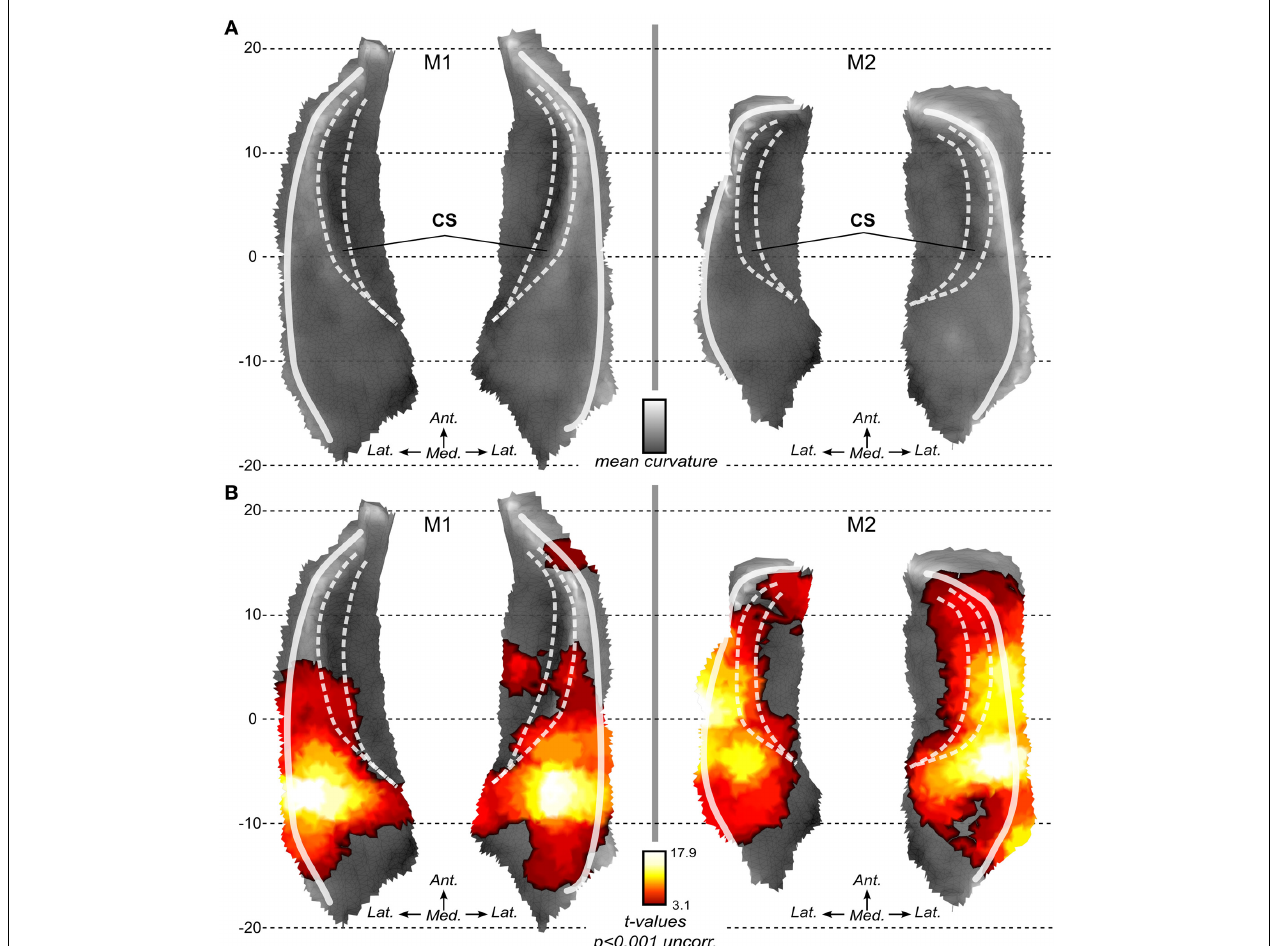
FIGURE 3 | Local flat maps and SPM maps for sound stimulation. (A) Local flattening allows the 2D representation of the 3D surface with minimal distortion as compared to full brain flattening. Mean curvature illustrates the original folding of the left and right STP in both monkeys. White lines